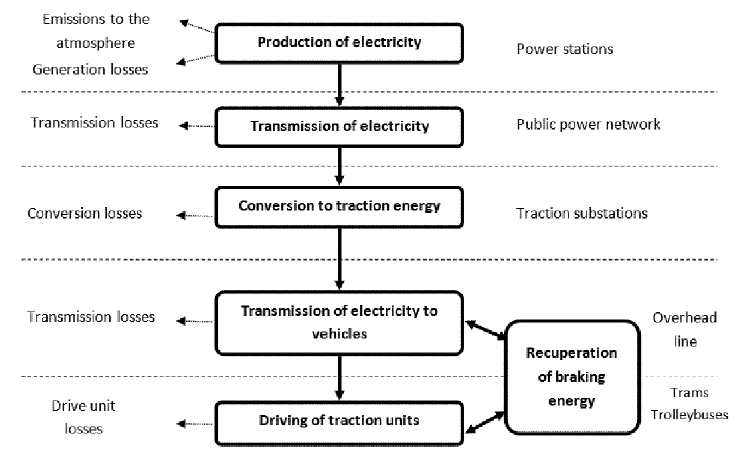
Fig. 1. The electricity flow diagram and associated